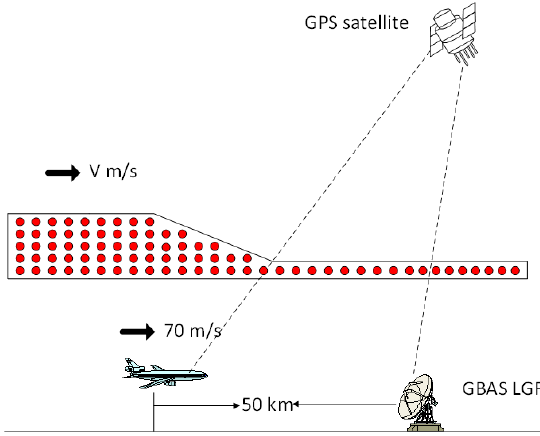
Figure 17. One of the worst-case scenarios.